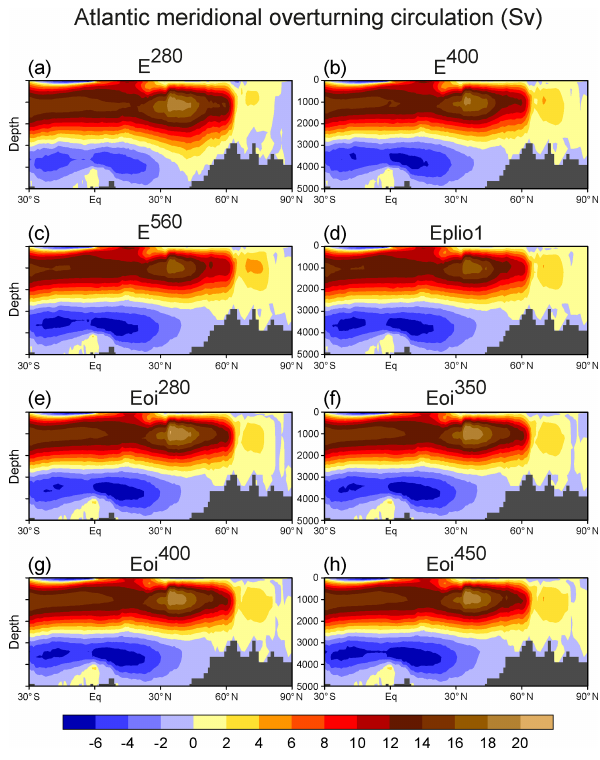
Figure 11. Streamfunction of the Atlantic meridional overturning circulation, averaged over the last 500 years. For a comparison of PlioMIP1 and PlioMIP2, see (d, g) . For the individual effects of CO 2 and Pliocene boundary conditions, see (b, e) , respectively.